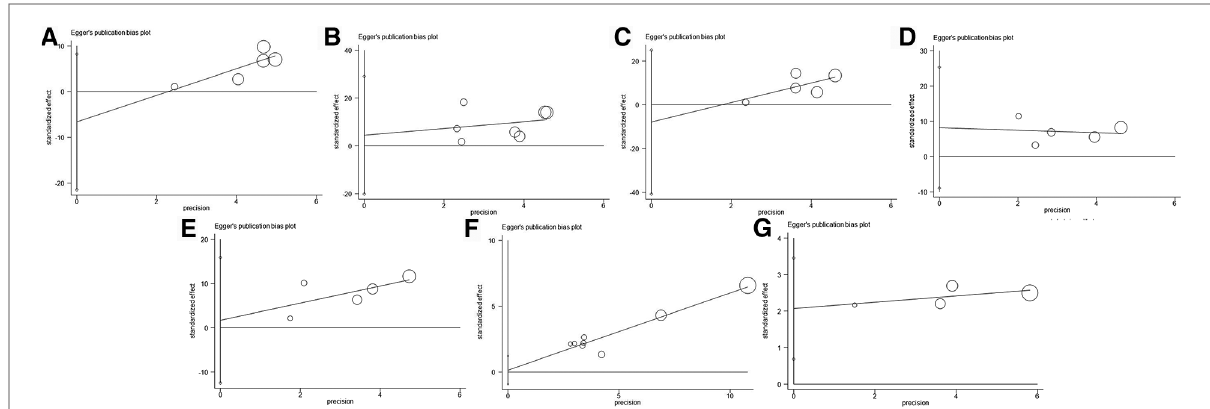
FIGURE 5 Egger ’ s publication bias plot for ( A ) age, ( B ) sex, ( C ) smoking history, ( D ) lymph node metastasis, ( E ) AJCC stage, ( F ) OS, and ( G ) RFS. AJCC, American Association of Cancer; OS, overall survival; RFS, recurrence-free